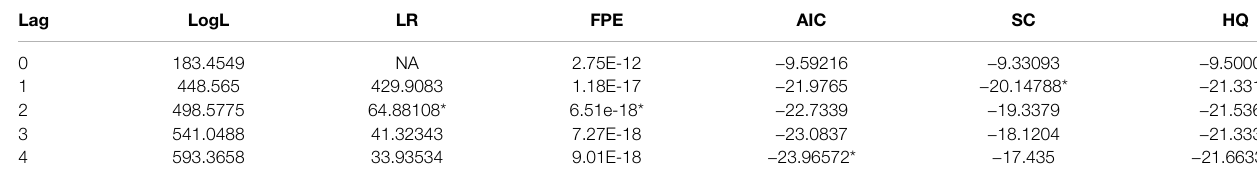
TABLE 3 | Selecting optimal lag according to VAR lag order.